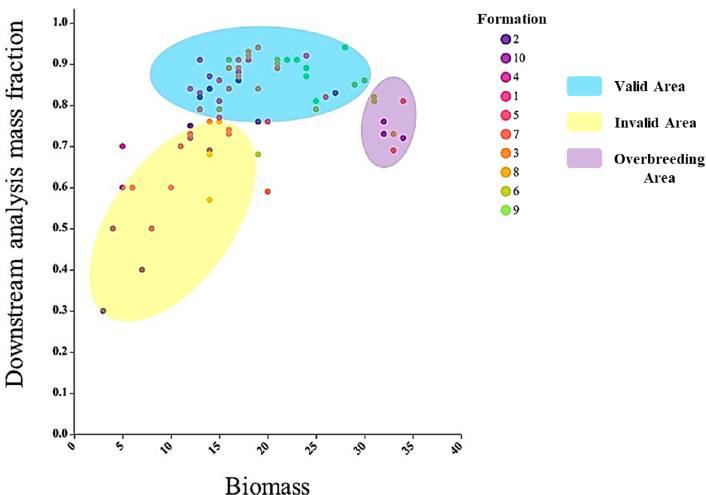
Figure 4. Quality control of DNA markers. The valid area meets both the medium biomass and downstream analysis mass fraction above 0.8, so it can be used for downstream analysis. The sequencing data in the biomass greater than 30 region is considered to be caused by microbial overgrowth, and insufficient biomass will seriously affect accuracy. So, the overbreeding area and invalid area also cannot be used for downstream analysis .